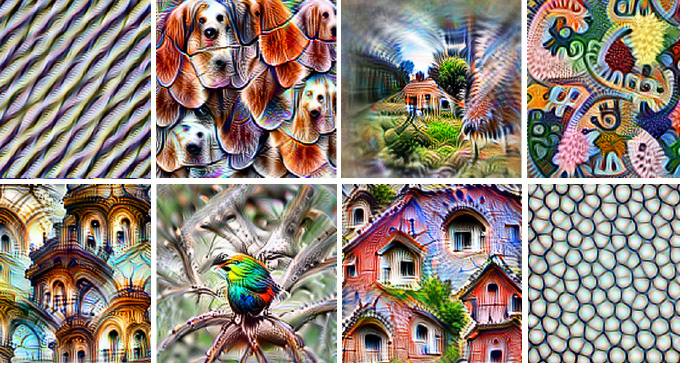
Figure 6. Various saliency maps. Figure from